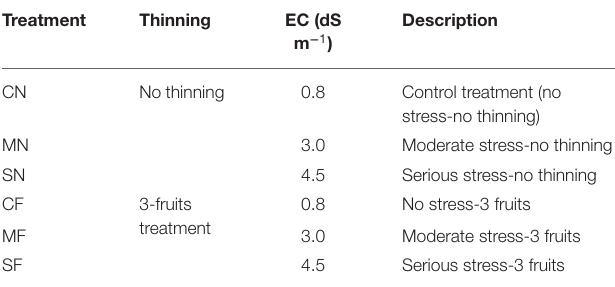
TABLE 1 | Salinity conditions and fruit thinning for each treatment.